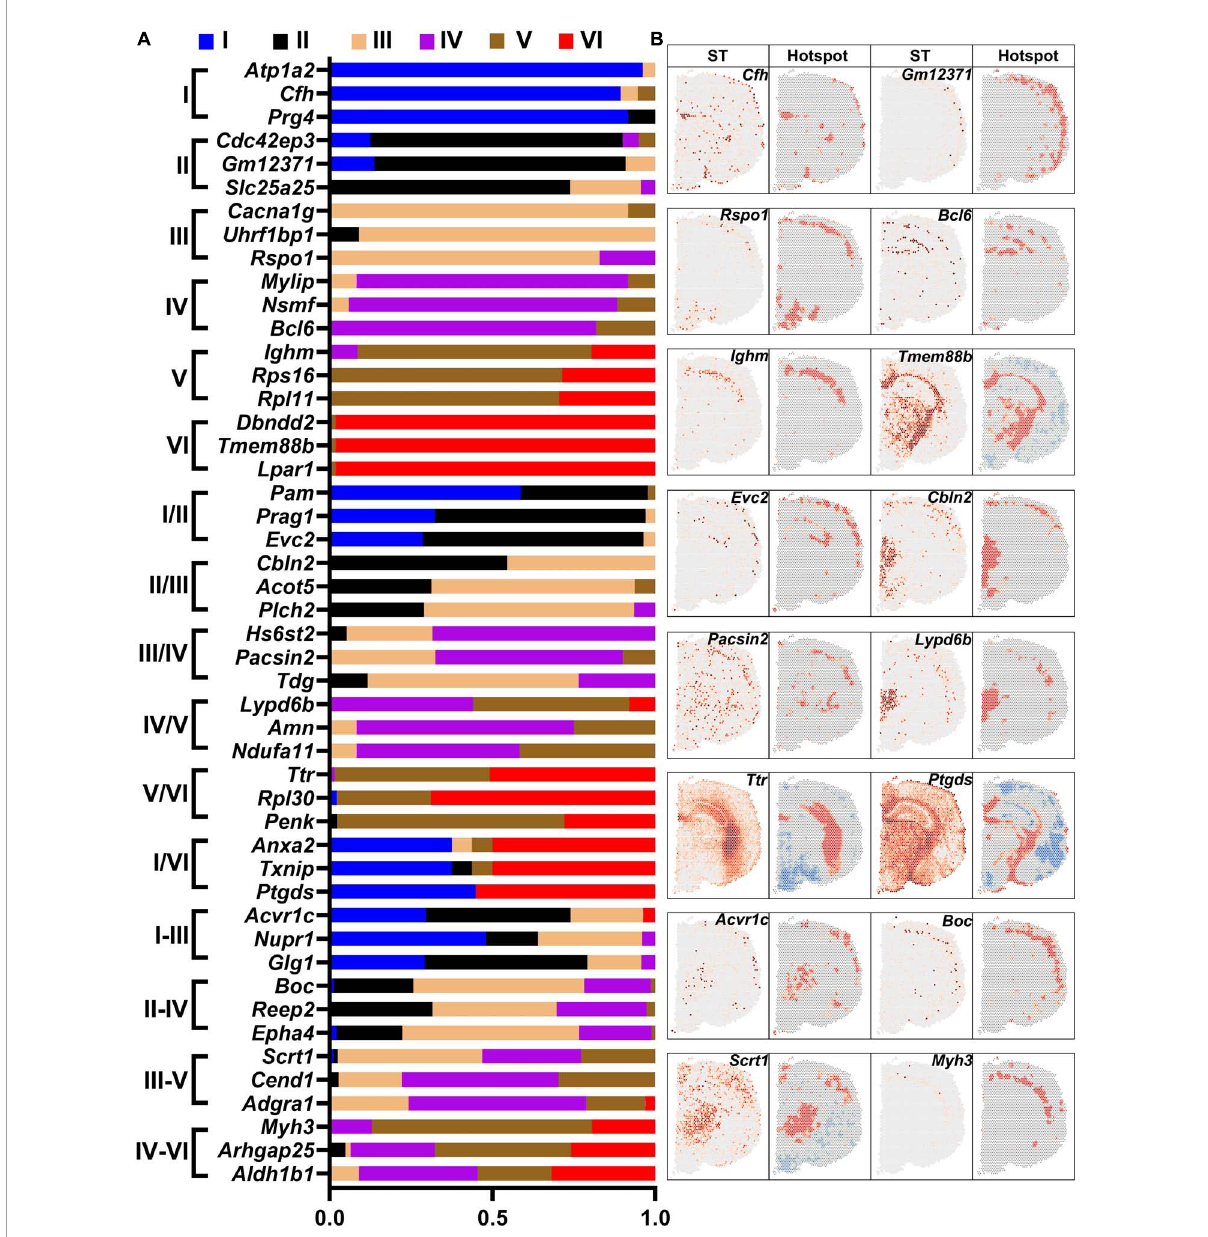
FIGURE7 Differentially expressed genes (DEGs) in the cortex layers. (A) Top 3 DEGs in the layers. (B) Typical DEGs. ST, spatial